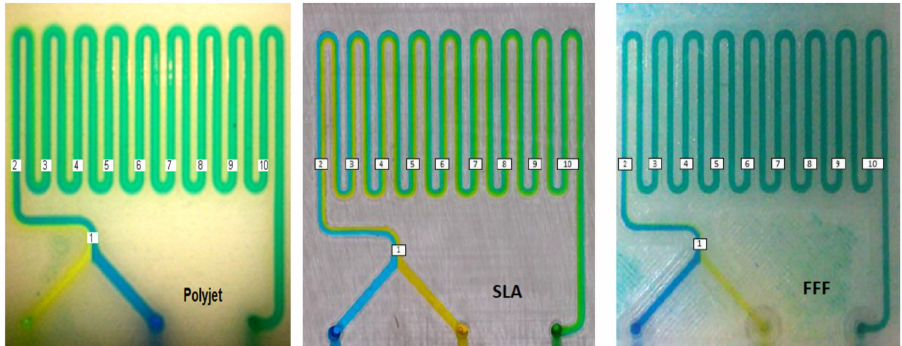
Figure 9. Regions of interest in the di ff erent microchannels.